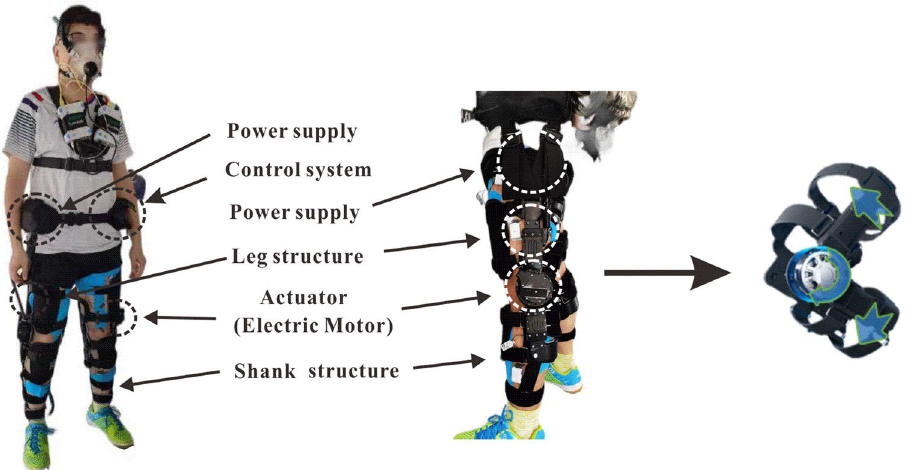
Figure 2. Mechanical design of the APAK